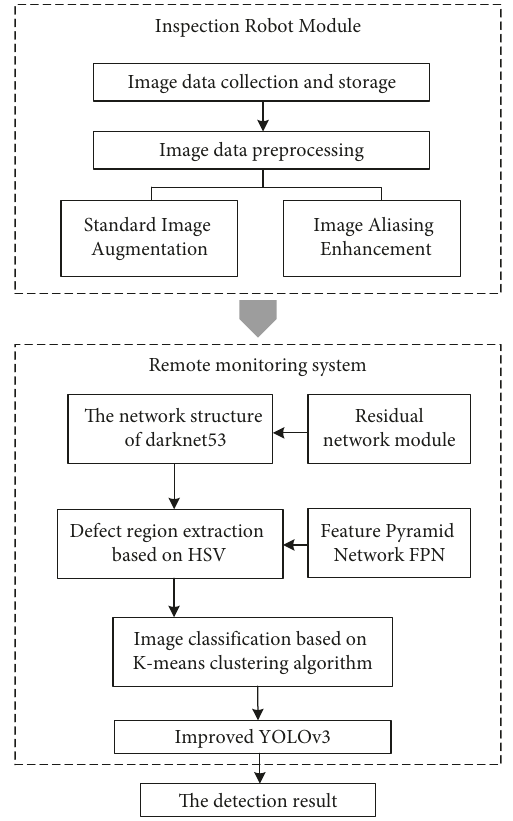
Figure 1: Overall scheme of robot inspection system for UHV